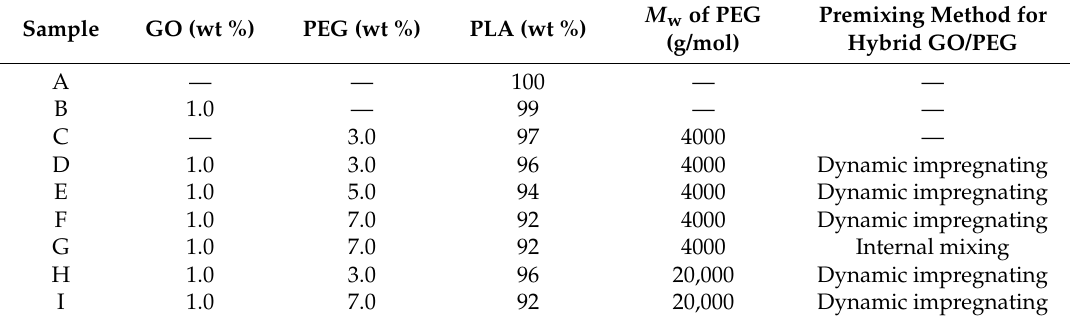
Table 1. Different formulations of poly-(lactic acid) (PLA)-based composites with the introduction of graphene oxide (GO)/polyethylene glycol